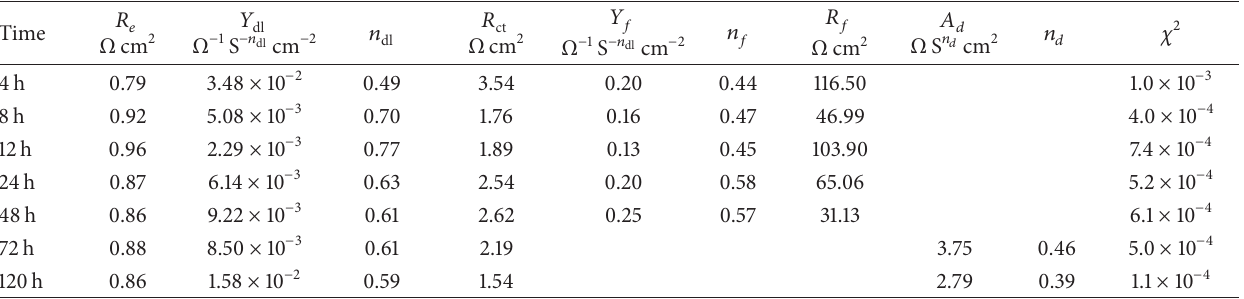
Figure 4: SEM morphology of P92 ((a) and (b)) after 120h of corrosion in molten carbonate. (b) is the enlarged figures in the rectangles for (a). (c) is the EDX composition profile across the line in (b). Table 2: Results of the CNLS fit to EIS data of